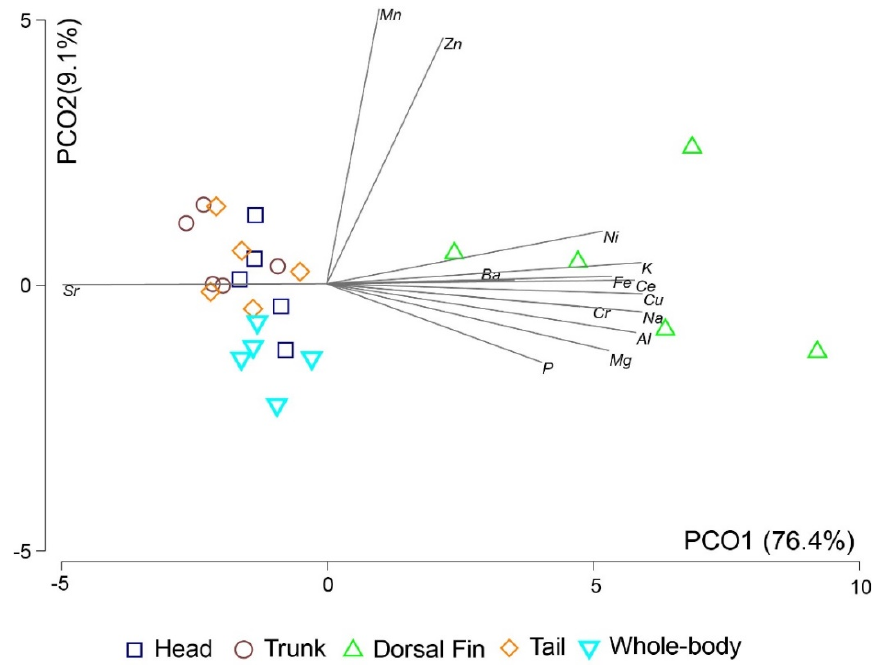
Figure 2. Principal coordinates analysis of the elemental fingerprints of the bony structures of four body parts (head, trunk, dorsal fin, and tail) and the whole body of long-snouted seahorses ( Hippocampus guttulatus ) cultured in Instituto de Investigaciones Marinas (IIM) (Galicia, Spain) ( n = 5). Vector overlay Pearson correlations of elemental composition with PCO axes are shown if |r| > 0.20.